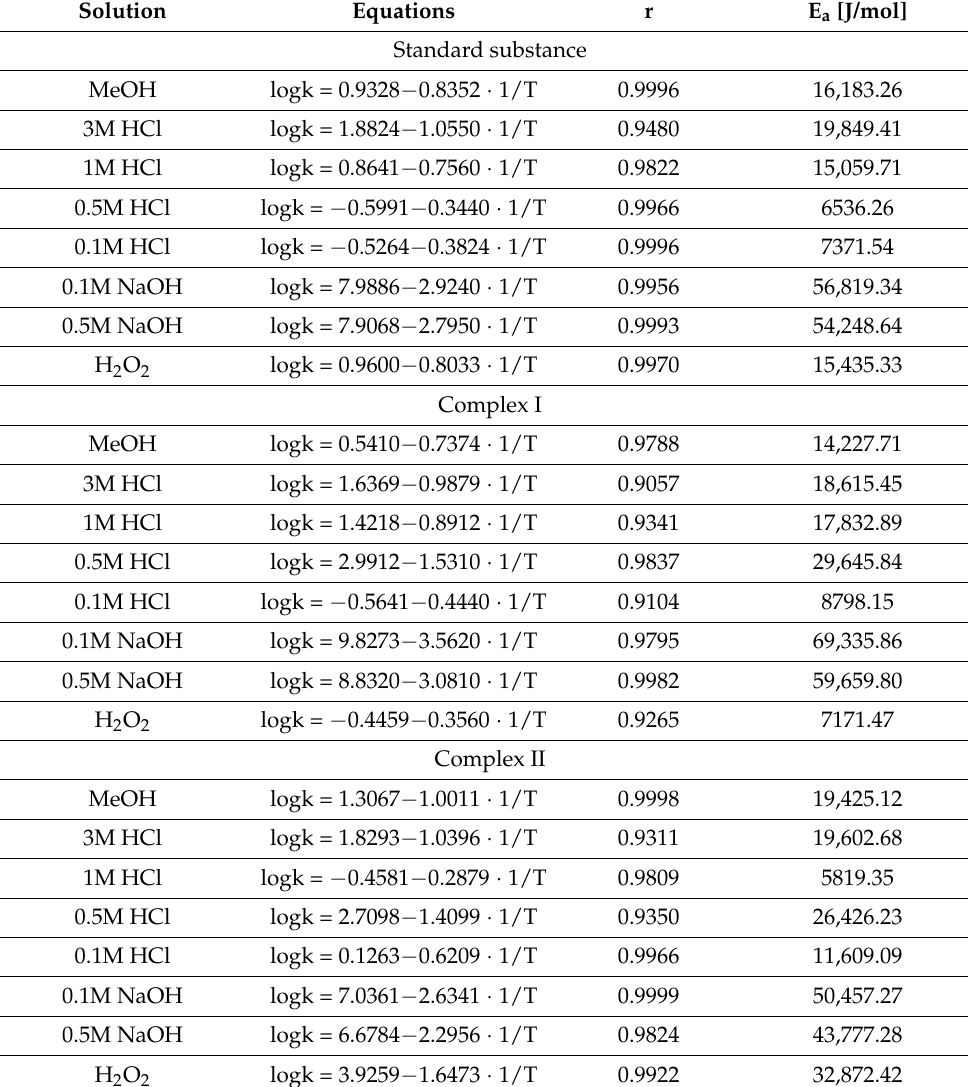
Table 4. Equations of straight curves, correlation coefficients (r), and activation energy (E a ) values determined for MTZ